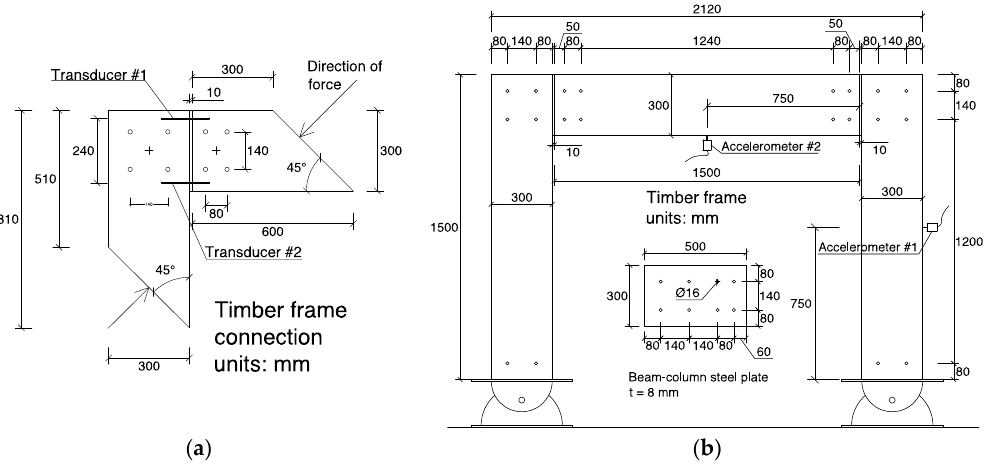
Figure 2. Laboratory specimens: ( a ) steel-timber connection; ( b ) 1500 mm × 1500 mm portal frame—all lengths in mm.